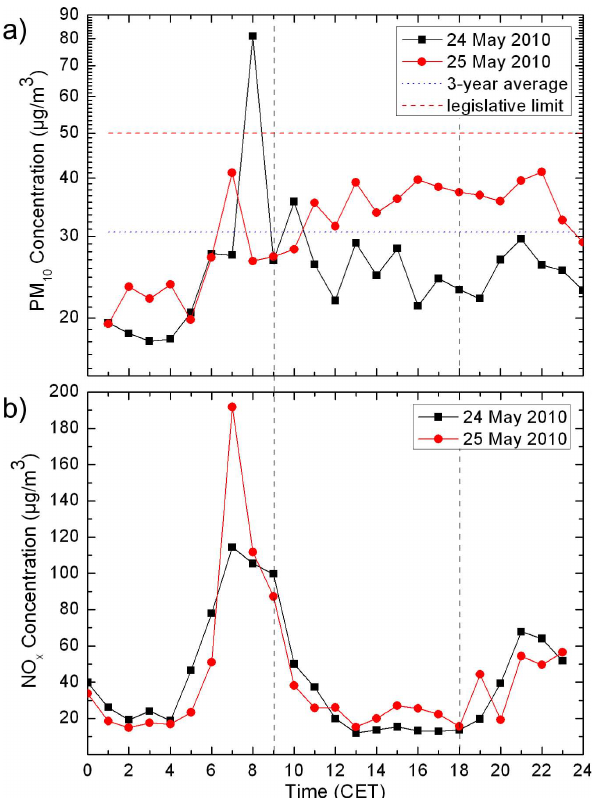
Fig. 6. Temporal evolution of PM 10 and NO x concentrations for the period of 24–25 May 2010, obtained from the ground-based mea- surements at the monitoring station in Nova Gorica. The intervals when LIDAR measurements are available are marked with vertical dashed